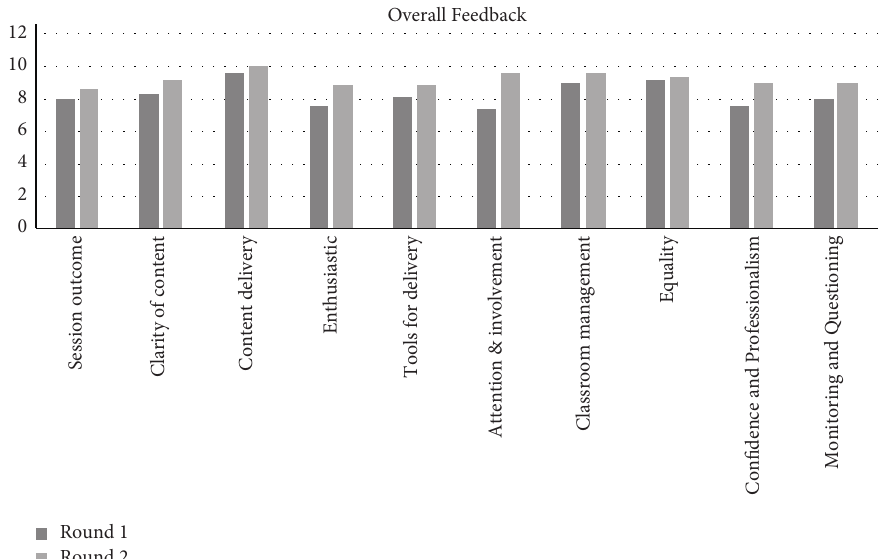
Figure 6: Overall feedback in round 1 (dark grey bars) and round 2 (light grey